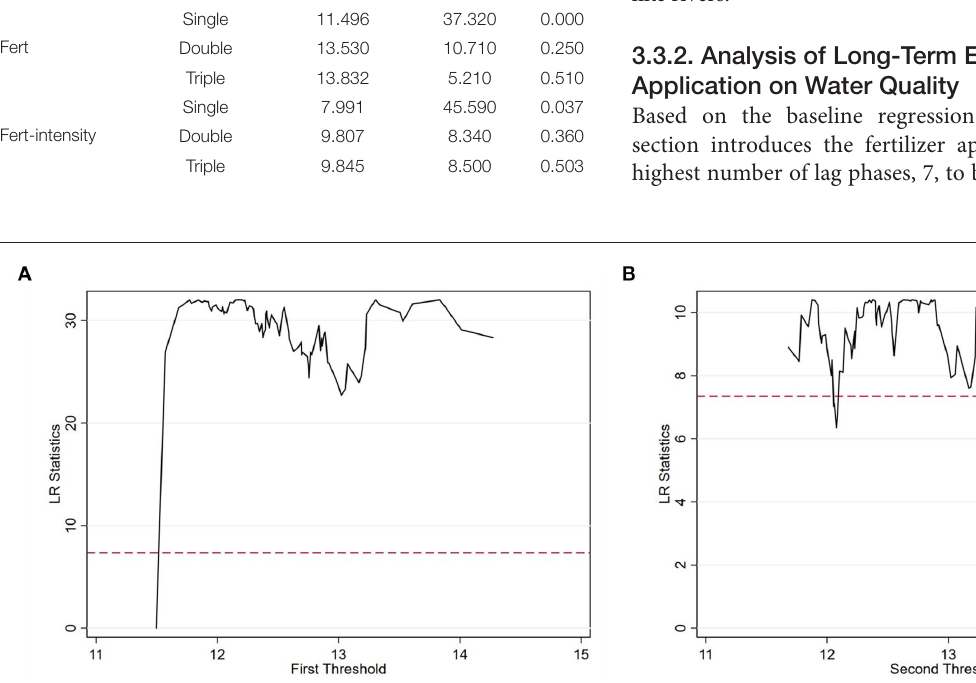
FIGURE 1 | LR Diagram with the threshold variable LnFert